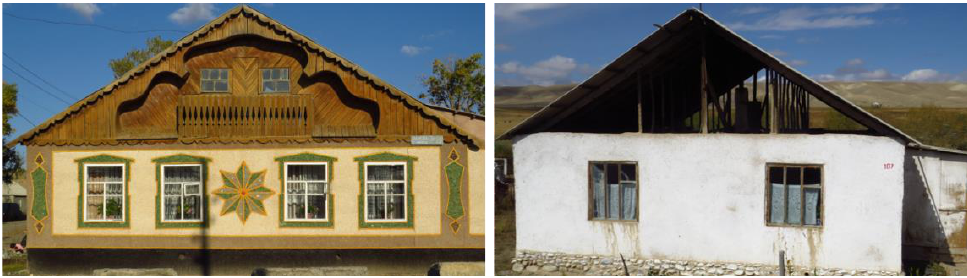
Figure 14. A decorative façade or exterior wall ( left ) and a whitewashed exterior wall ( right ).